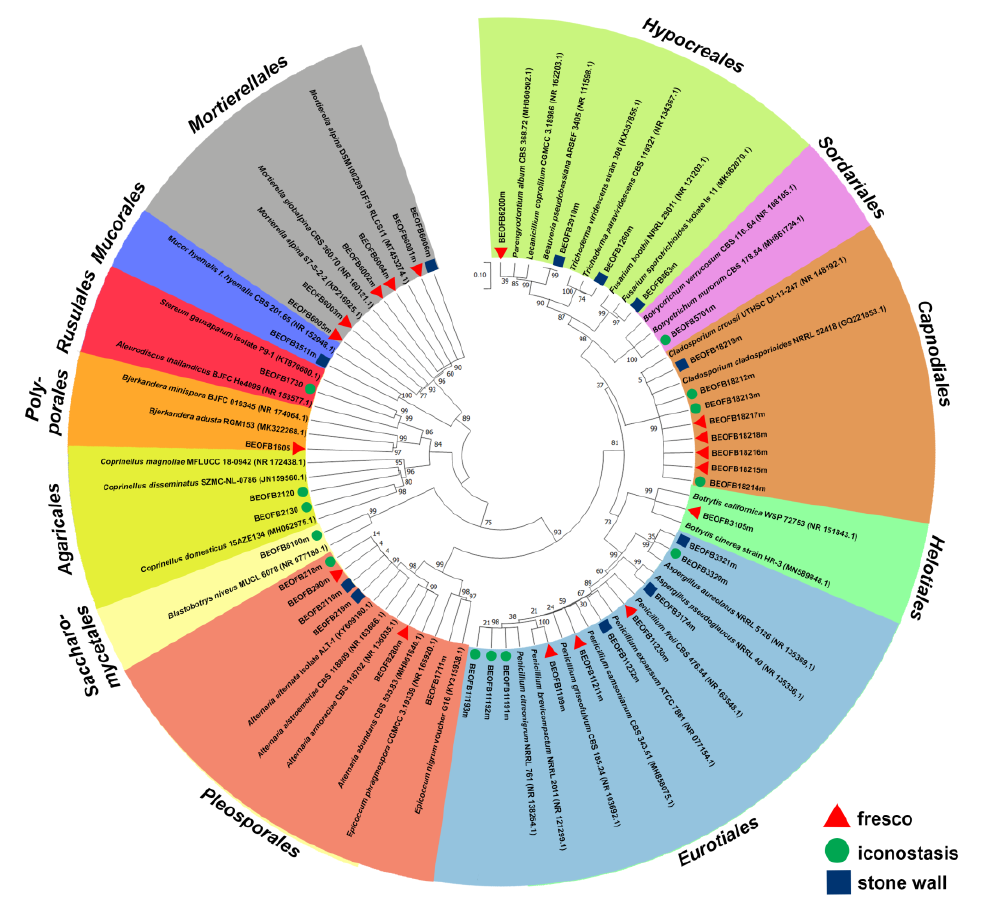
Figure 7. Maximum likelihood tree of ITS region of culturable fungi isolated from the Cave Church of Sts. Peter and Paul.